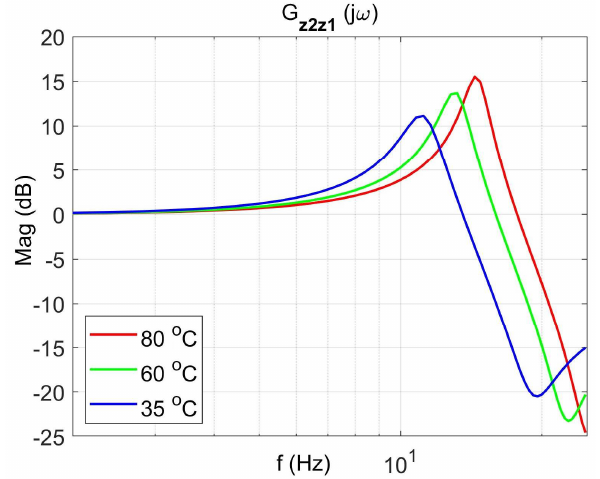
Figure 6. Vibration transmissibility functions of the absorber as a function of frequency for selected temperatures 25 ◦ C, 60 ◦ C, 80 ◦ C, the transfer function G z 2 z 1 .